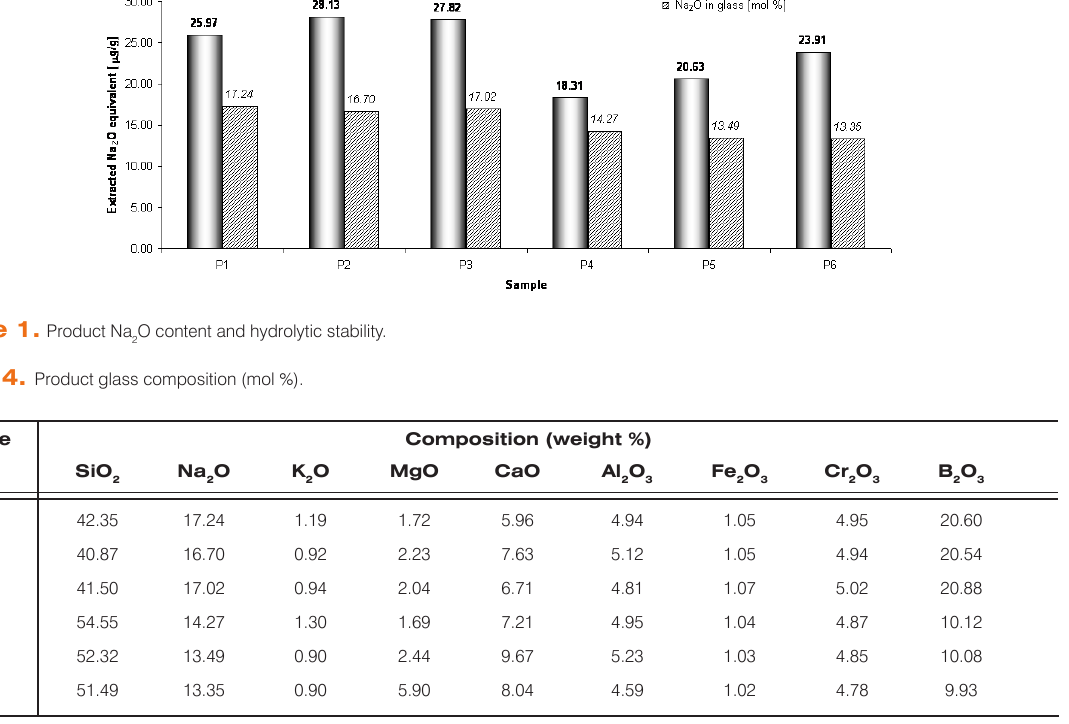
Table 5. Product glass properties.